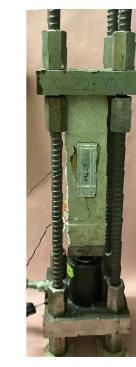
Figure 6. Setup for the shrinkage and creep experiment: ( left ) sketch of the cuboid concrete specimens with their dimensions, loaded within a steel frame, and ( right ) picture of the